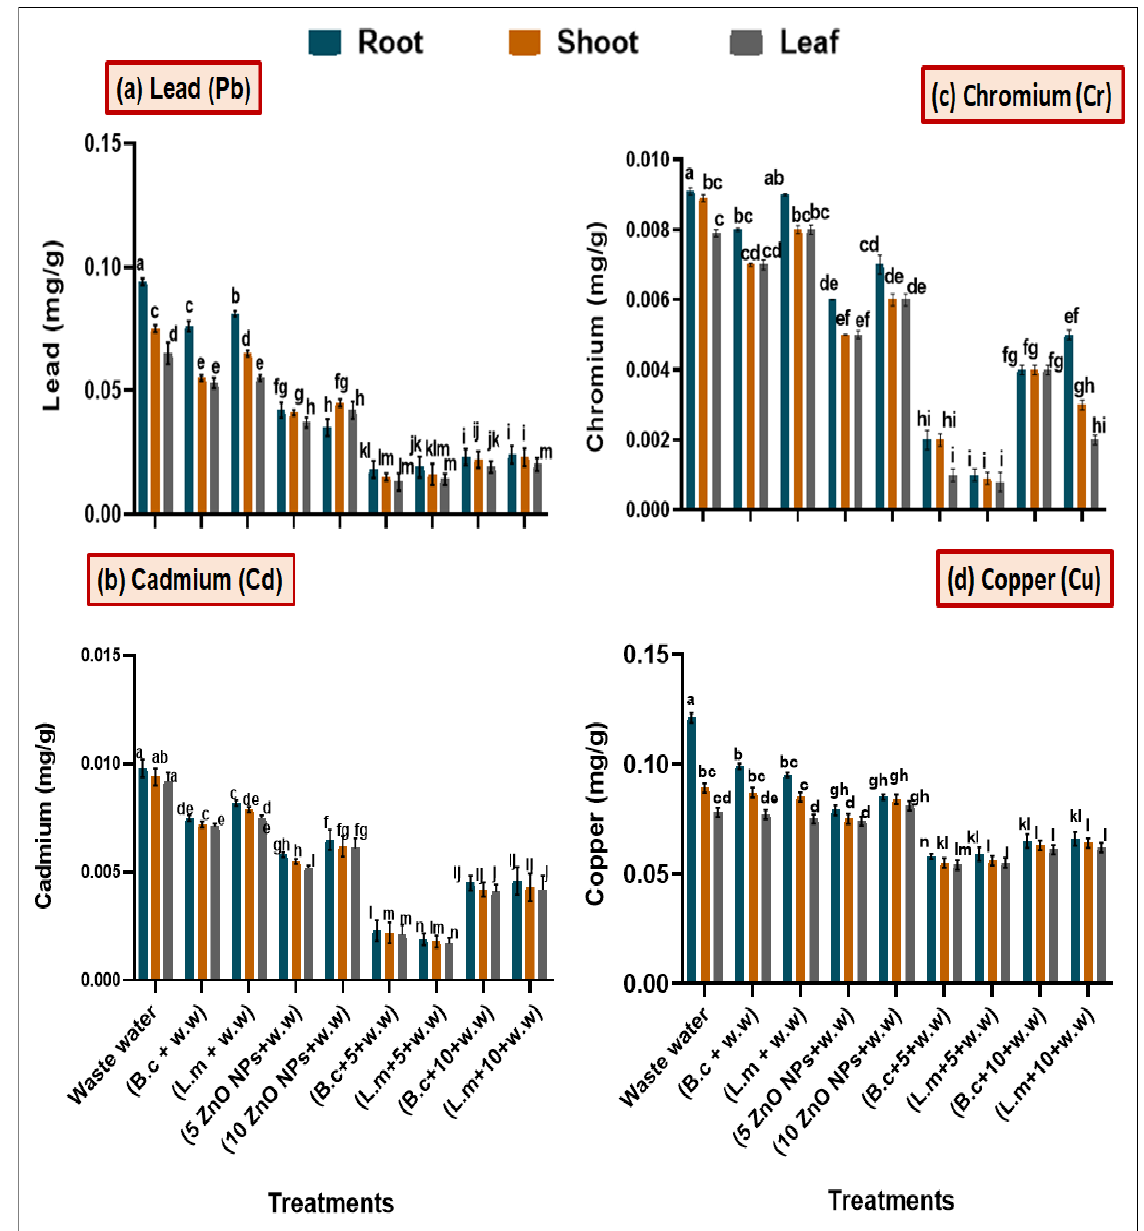
Figure 5. Synergistic effect of the bacterial strains ( B. cereus and L. macroides) and ZnO NPs (5 and 10 mg/L) on heavy metals ( a ) Lead (Pb), ( b ) Cadmium (Cd), ( c ) Chromium (Cr) and ( d ) Copper (Cu) contents in root, shoot and leaf of rice grown in heavy metal contaminated water. Error bars show means of standard error ( ± S.E.) of three replicates ( n = 3). Different alphabets appeared in superscript on each number showed statistically significant at 5% probability level.